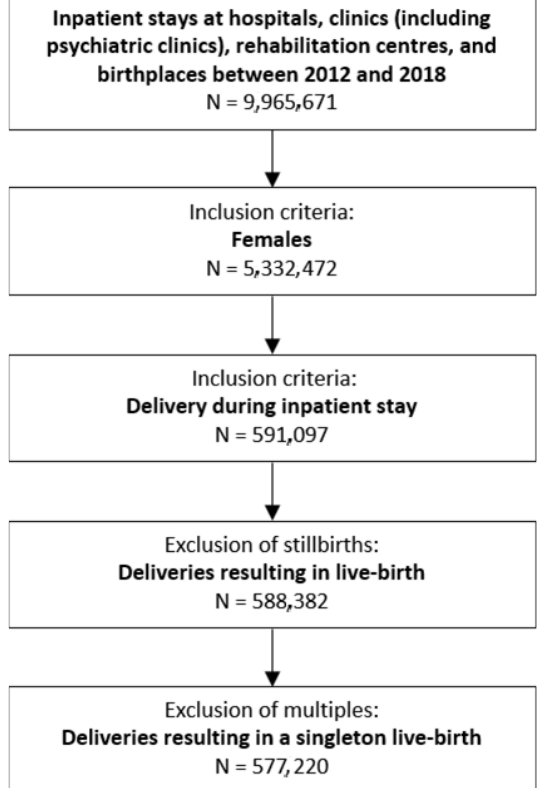
Figure 1. Flow chart of cohort enrolment (numbers separately for each year in Table S2).